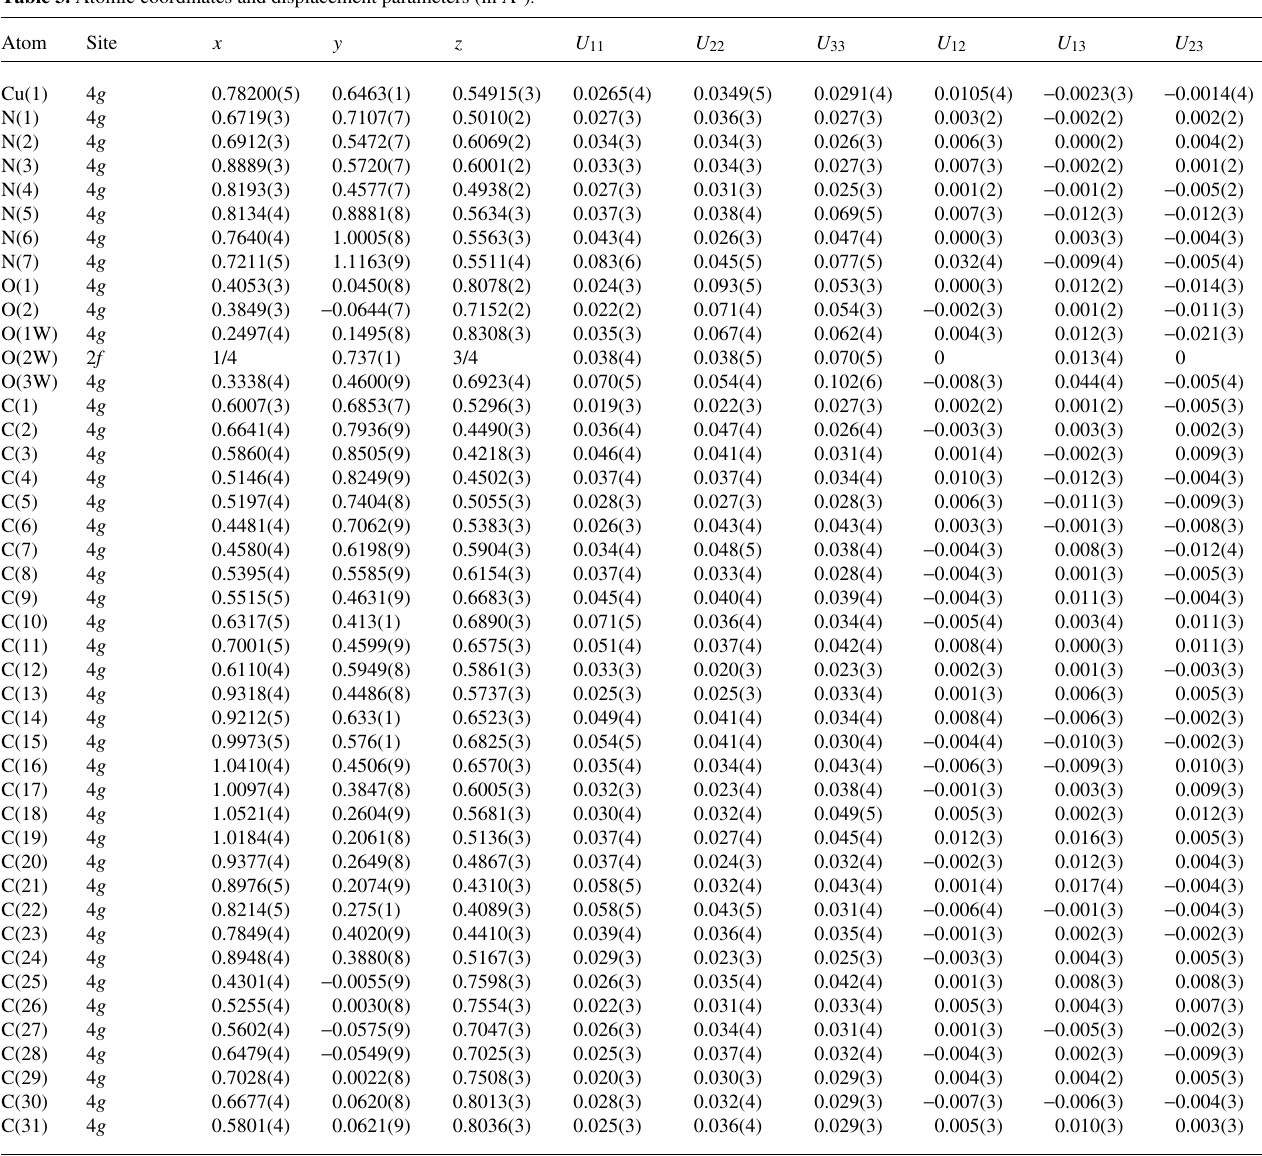
Table 3. Atomic coordinates and displacement parameters (in Å 2 ) .